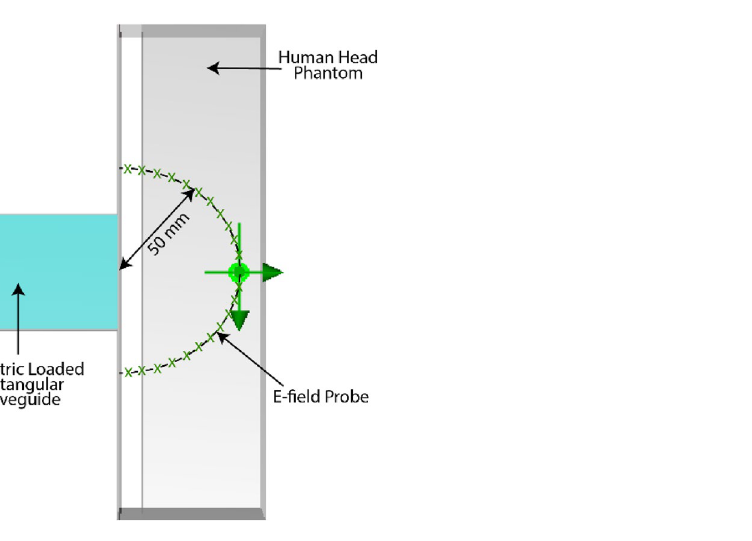
Figure 4. Top view of the E-field probe setup at a 50 mm radius inside the human head model from the center of the waveguide-skin interface.